Question: In a single sentence, describe what this figure presents.
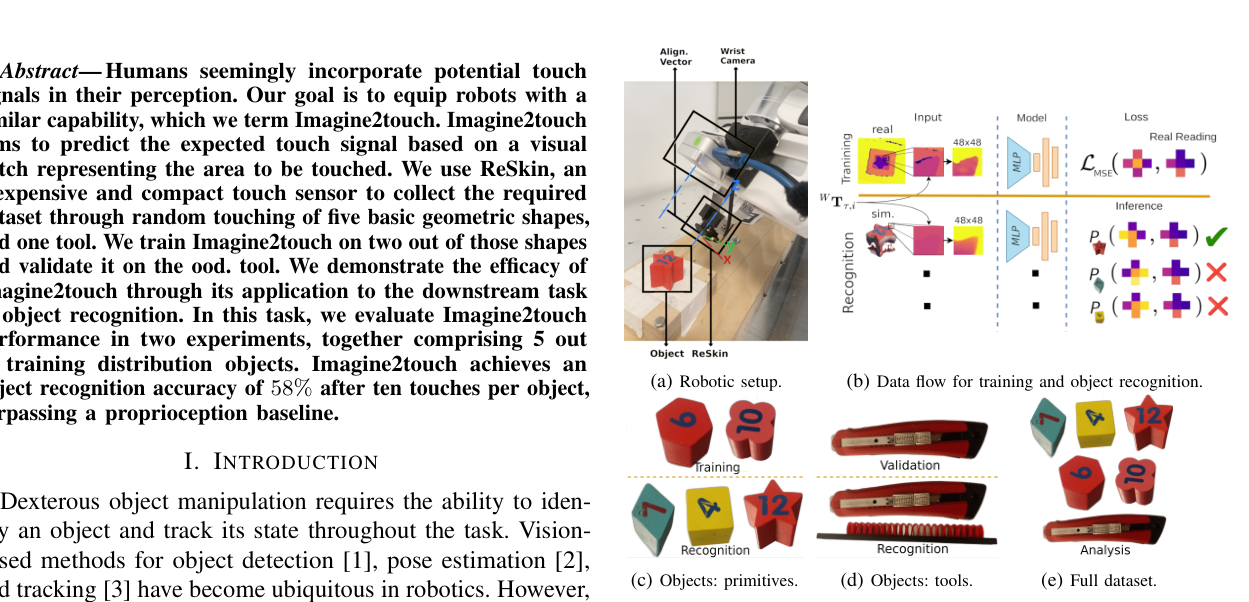
Answer: (a): Robotic setup for our approach. The alignment vector shows the direction on which the robot moves for collecting one data sample to pair the wrist camera and ReSkin readings. (b): Data flow for training our model and using its inference in object recognition. The depth patch is cropped and processed from the full image using the end-effector pose T W τ,i to match the touch area. It is then passed to the model, which we optimize using the MSE-loss between its output and the real touch reading. At recognition time, the robot has access only to possible 3D renderings. We use the probabilistic touch model in Sec. II for recognition. (c): Objects set: primitives. First row: primitives used for training the model. Second row: primitives used for one instance of the object recognition experiment. (d): Objects set: tools. First row: Tools used for validating the model. Second row: Tools used for the second instance of the object recognition experiment. (e): Full objects dataset us